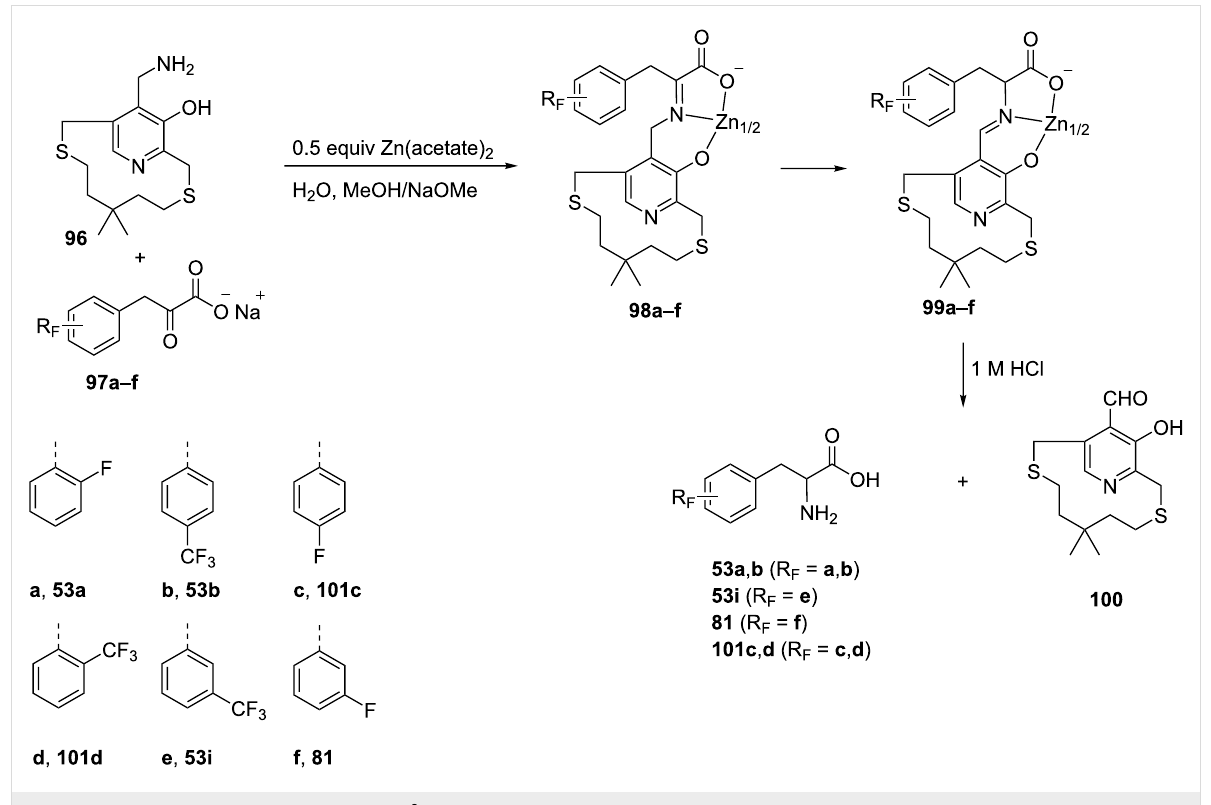
Scheme 22: Synthesis of FPhe derivatives via Zn 2+